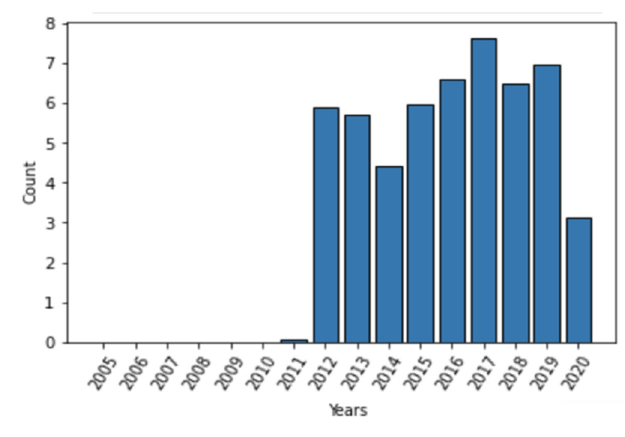
Figure 8. Complaints reported by bystanders over the years.